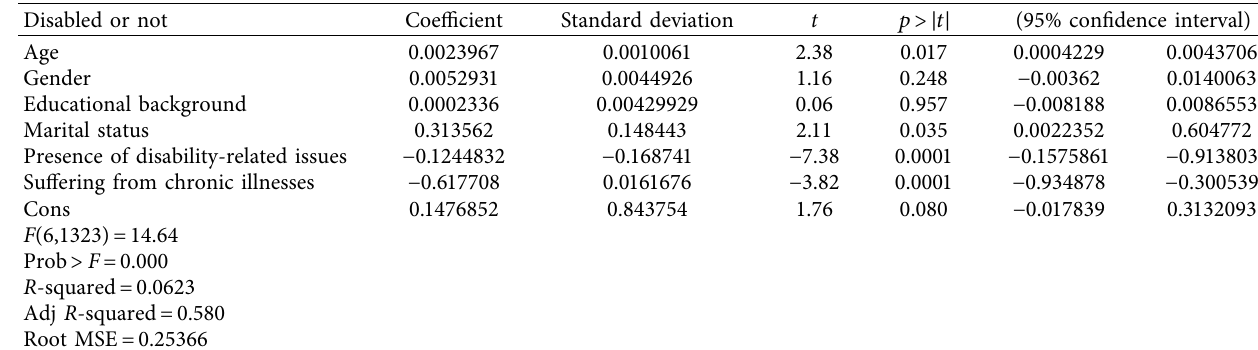
Table 3: Results of the multiple regression analysis on being disabled or not.